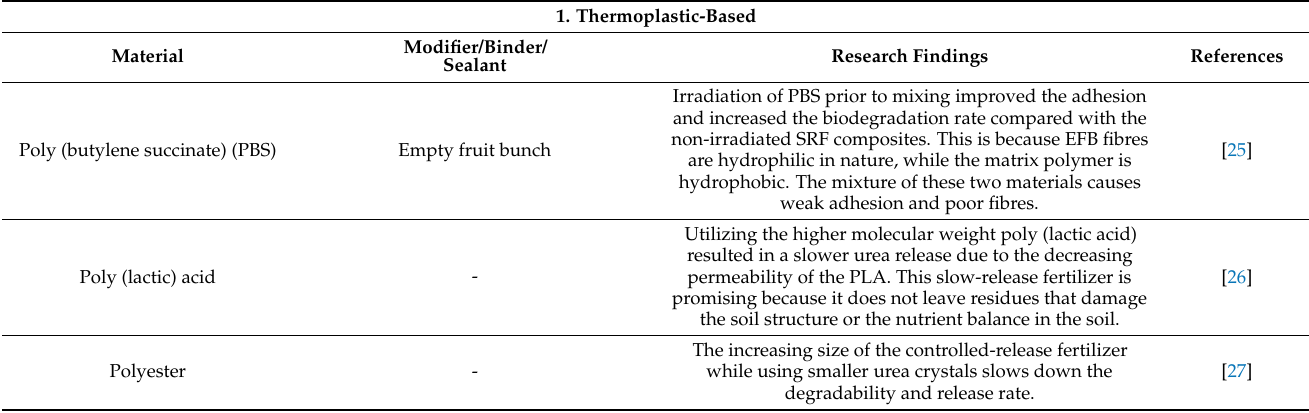
Table 1. Organic materials commonly used to encapsulate urea